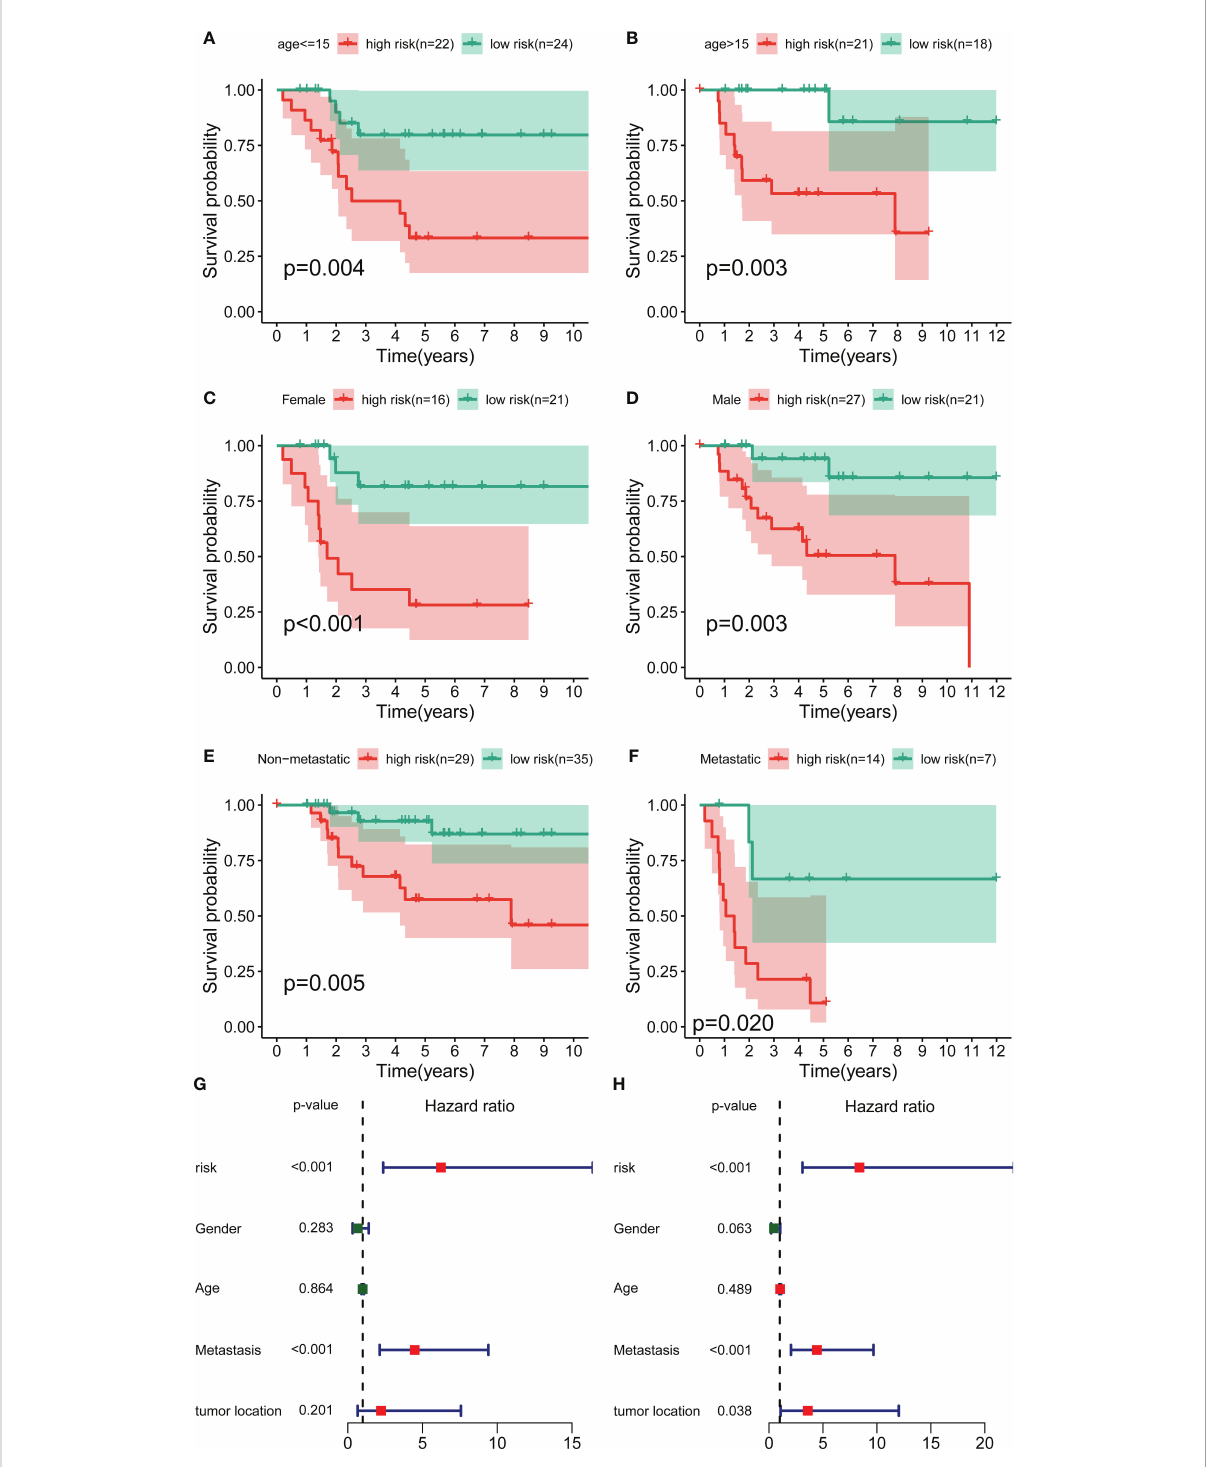
FIGURE 3 Independent prognostic value of the novel CRL signature. (A – F) K – M survival curves of overall survival strati fi ed by age, gender, and metastasis status between low- and high-risk groups. (G, H) Univariate and multivariate Cox regression analyses demonstrated the novel CRL signature as an independent prognostic factor for